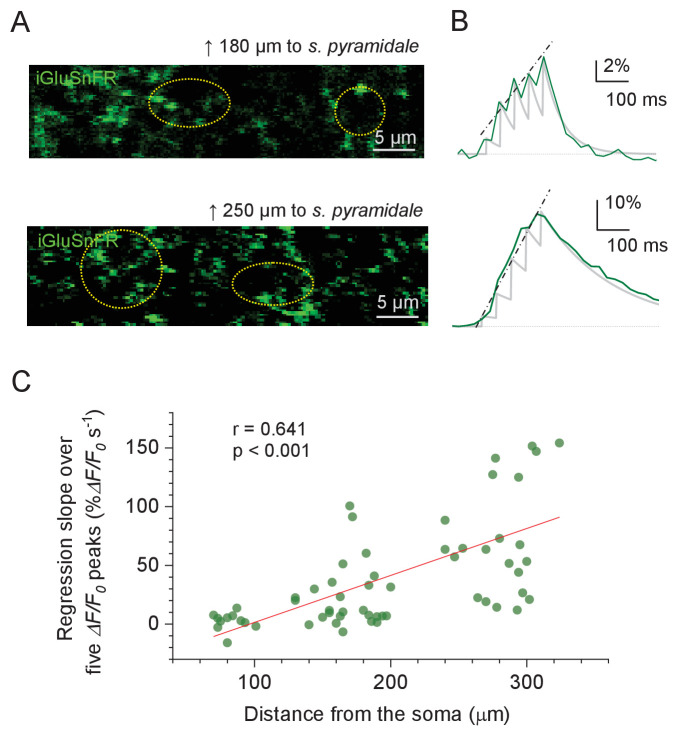
Optical (multi-synaptic) glutamate signal evoked by short bursts of Schaffer collateral stimulation at varied distances from s.pyramidale.(A) Examples of recorded ROIs (iGluSnFR green fluorescence channel, dotted ovals) in s. radiatum, with groups of stimulation-responding tentative axonal boutons expressing iGluSnFR, at different distances to the s. pyramidale border (as illustrated in Figure 3A; distance reference shown is measured to the horizontal midline of the area shown; distance to each ROI was measured to the ROI centroid). (B) ROI-average iGluSnFR responses (green line, temporal resolution ~25 ms) to five stimuli 50 ms apart. The underlying sensor signal kinetics (light grey line) was reconstructed using the fitting algorithm ΔF/F0=∑Aiexp(−(t−Δt⋅(i−1))⋅τ−1) (i = 1,..., 5) where Ai is the ith signal amplitude (fitted directly to the recoded amplitude), Δt = 50 ms, and the decay constant τ obtained directly from fitting the signal tail after the fifth pulse; dash-dotted lines, the linear regression line for the five ΔF/F0 response peaks (at the five pulse onsets). (C) Average slope of linear regression for the five ΔF/F0 response peaks as shown in (B), plotted against the distance from the s. pyramidale. (n = 61 boutons from N = 7 animals / slices).